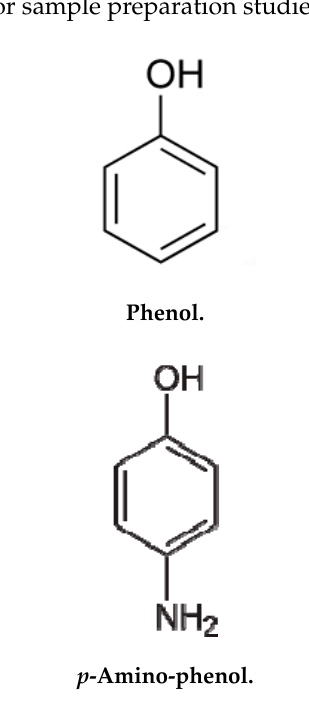
Figure 8. Chemical structures of phenol and p -nitro-phenol.